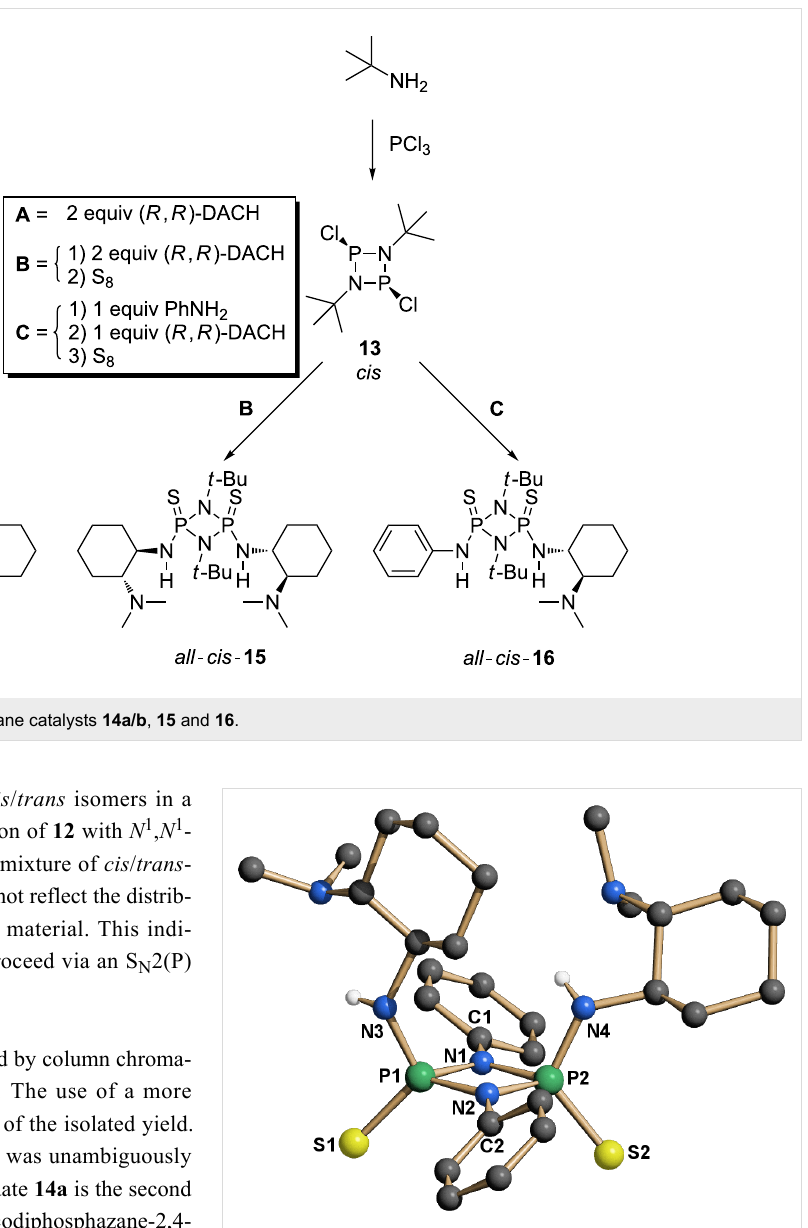
for N(ring)-aryl-cyclodiphosphazanes, in which, dependent on the substitution pattern either cis or trans -isomers are favored [42]. We thus employed known aliphatic cis -[ClP( μ -N t -Bu)] 2 13 (Scheme 3) as starting compound, although a slightly decreased acidity of NH-protons can be expected because of the electron-donating effect of the tert -butyl moiety. Indeed when comparing the 1 H NMR spectra of catalysts 14a and 15 , an upfield shift of NH-protons for 15 is evident ( Δδ = 0.4